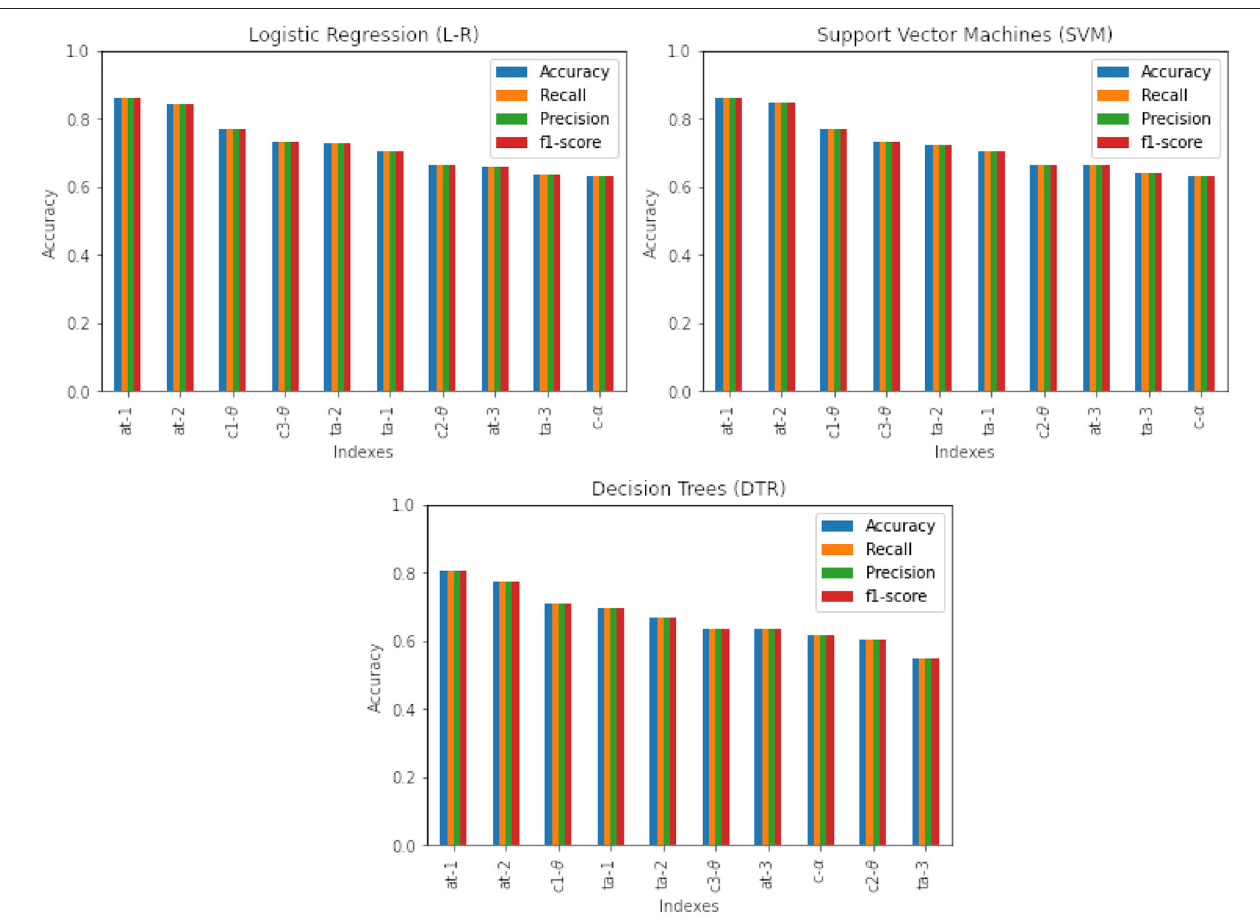
FIGURE 6 | Classification results with high-level features across models with different learning techniques.